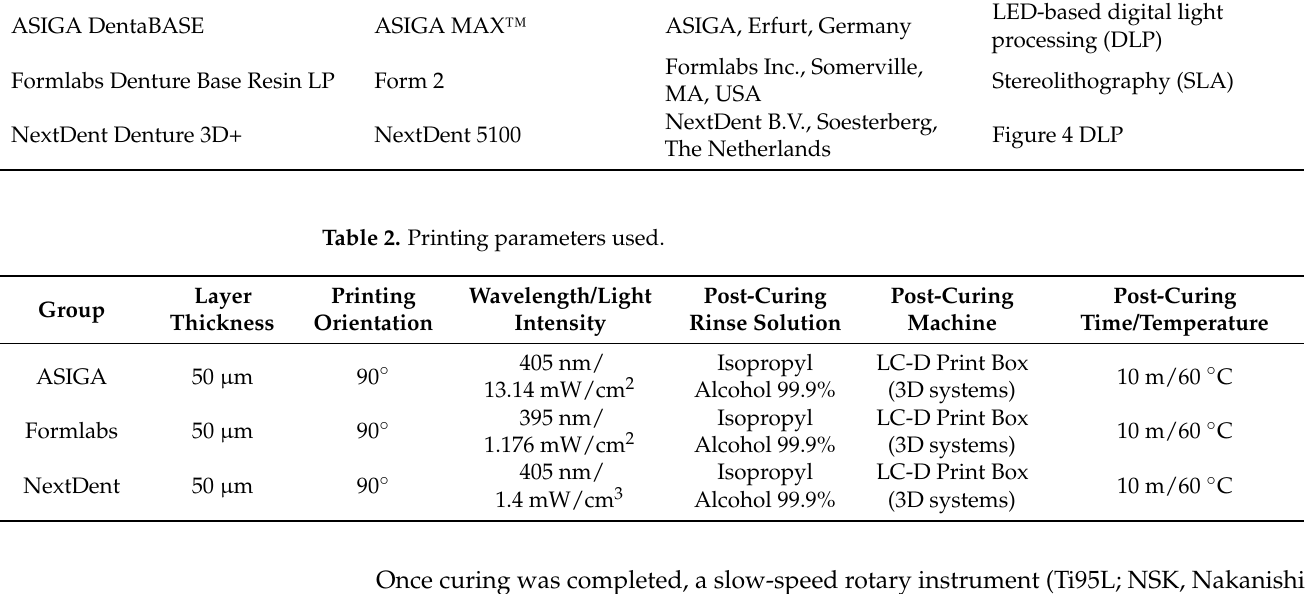
Table 1. Three-dimensional-printed materials and printers used in this study.